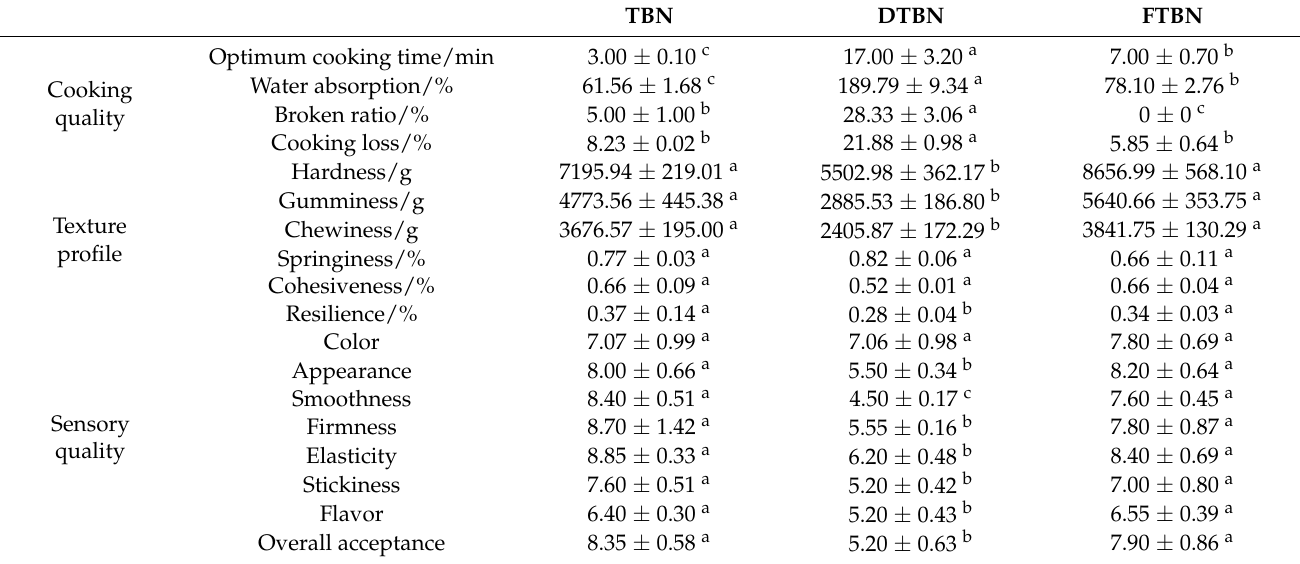
Table 1. Cooking, textural, and sensory qualities of cooked